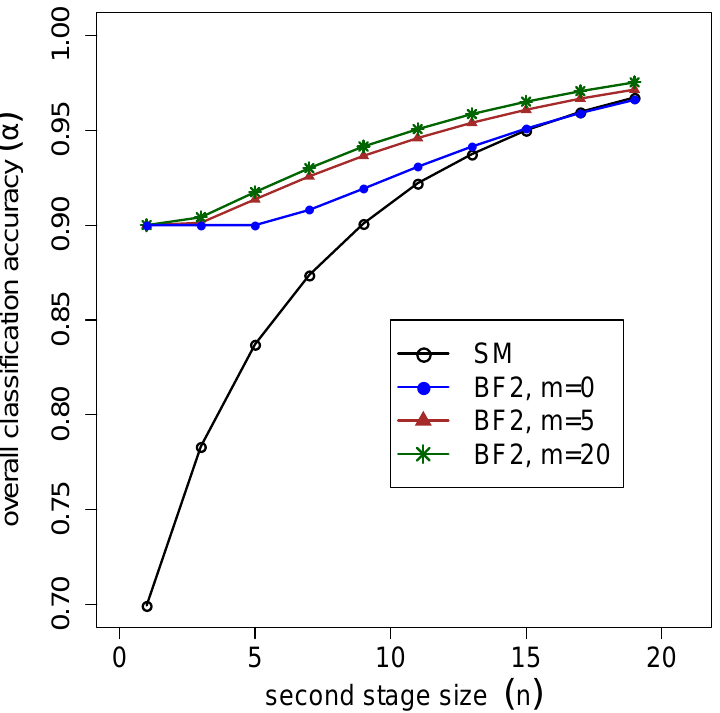
Figure 5. Comparison of the overall classification accuracy α for Simple Majority (SM) and the 2-stage Bayesian approach (BF2) as a function of m and n , the first stage and second stage sizes, for p 1 = 0.9, θ = 0.7, a = 6 and b = 4. BF2 consistently outperforms SM. Implementing the 2-stage testing improves accuracy, although the marginal effect of adding further tests ( m )